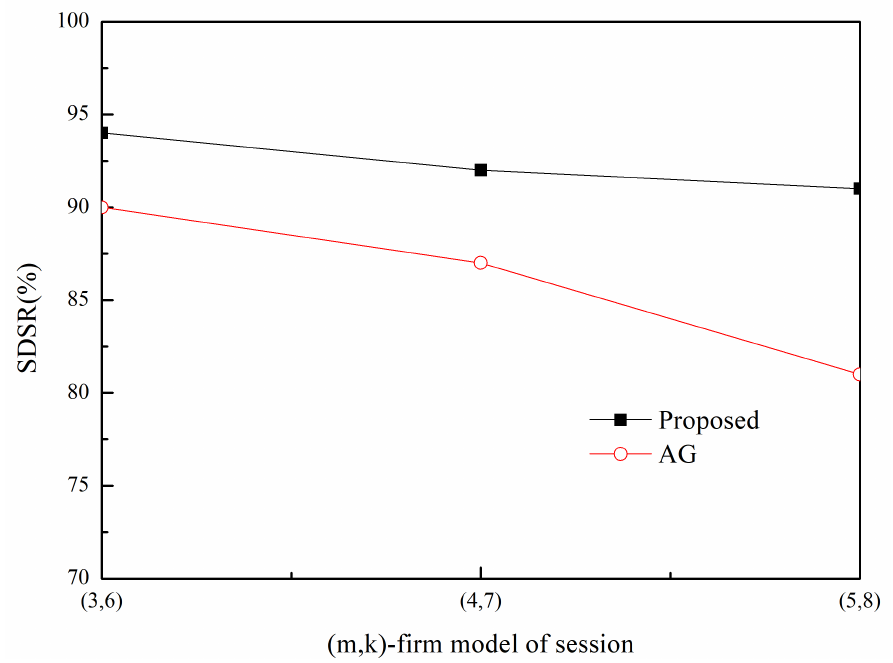
Figure 4. SDSR for (2,5)-firm